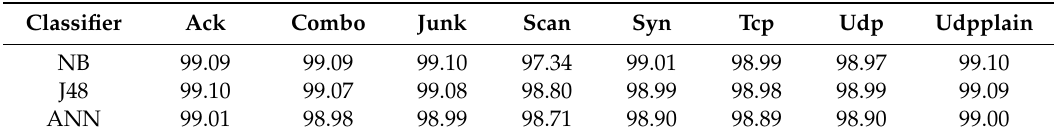
Table 2. Detection accuracy with feature